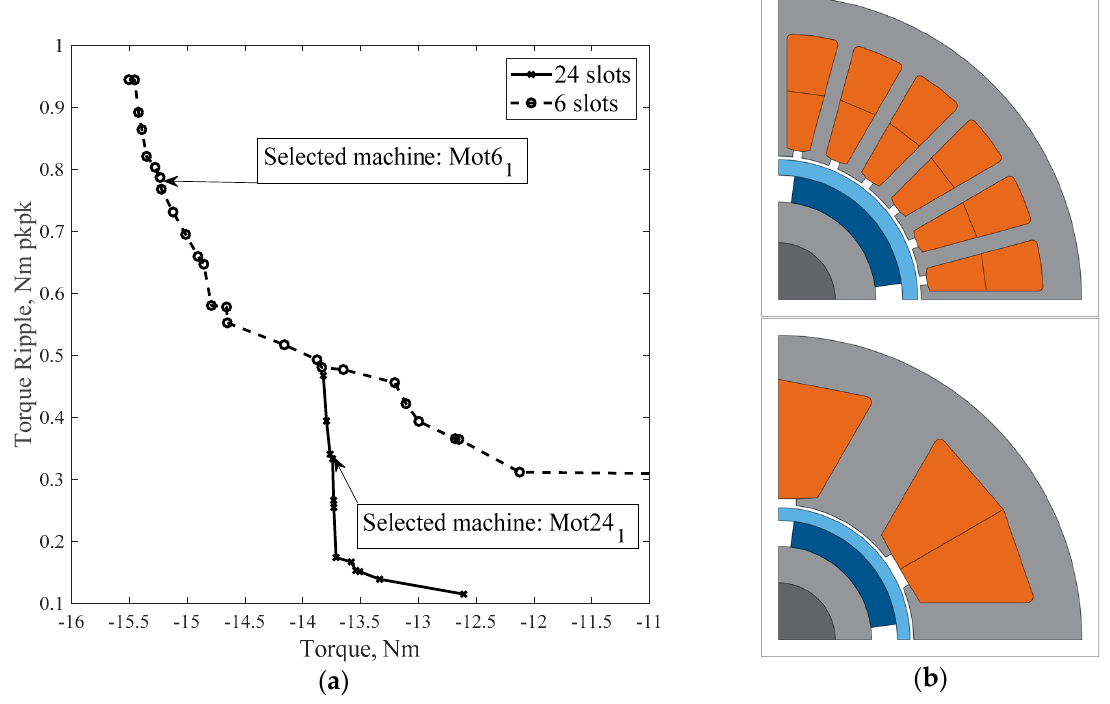
Figure 5. Pareto front of the T/ ∆ T run ( a ) and selected 6-and 24-slot machines ( b ).